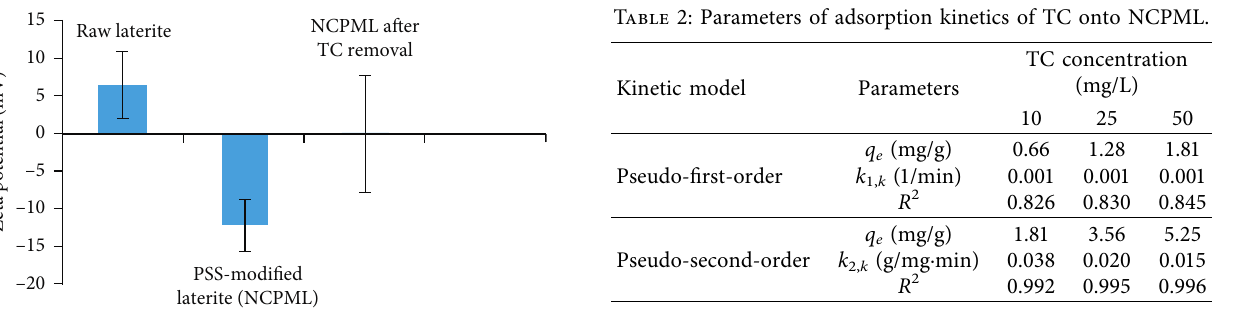
Figure 10: The ζ potential of laterite soil and PSS-modified laterite (NCPML) and NCPML after TC adsorption (pH 4).